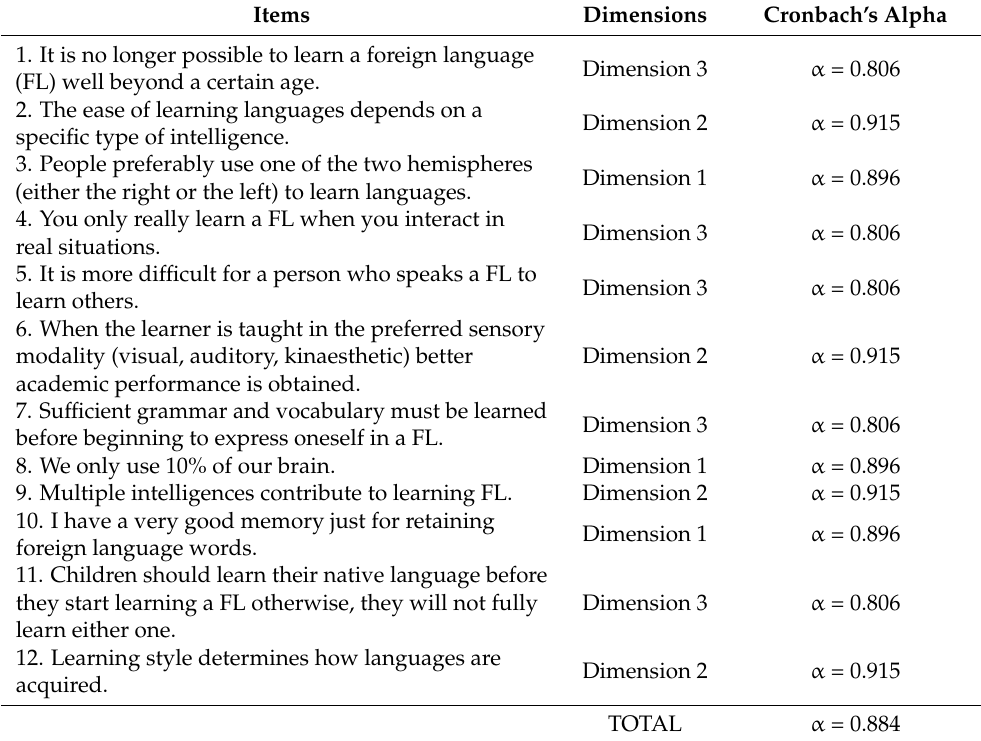
Table 1. Items of the final questionnaire and dimensions for data collection.